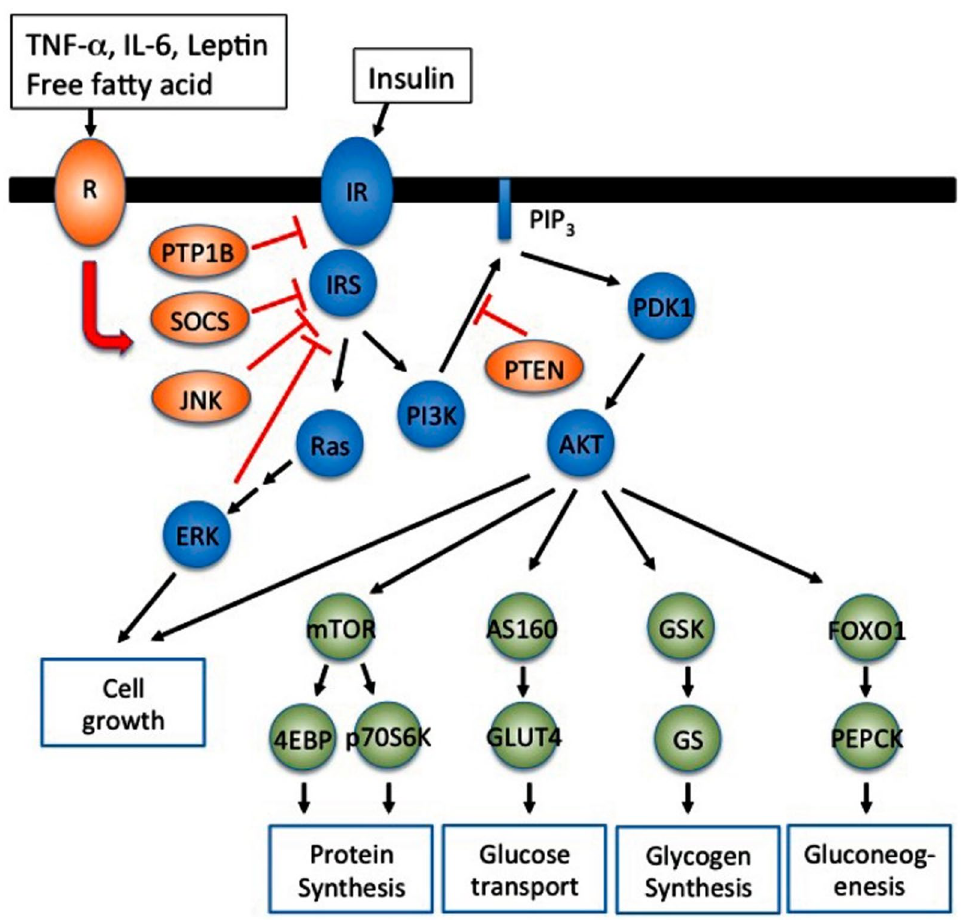
Fig. 1 Inflammatory adipokines suppress insulin signaling resulting in insulin resistance. IRS1/2 phosphorylated on specific tyrosine residues activates the phosphatidyl inositol 3-kinase (PI3K)-AKT/protein kinase B (PKB) pathway and Ras-mitogen-activated protein kinase (MAPK) pathway. PI3K-AKT signaling pathway regulates metabolic processes such as glucose uptake(muscle and adipocytes), glycogen synthesis (muscle and liver), protein synthesis(muscle and liver), and gluconeogenesis (liver). Inflammatory signals, TNF-a, IL-6, Leptin and saturated free fatty acid, activate inhibitory molecules such as SOCS and JNK to suppress insulin signaling resulting in insulin resistance. PI3K-dependent PDK1 activation is negatively regulated by phospholipid phosphatases such as phosphatase and tensin homolog (PTEN) that degrade PIP3 [86]. doi: